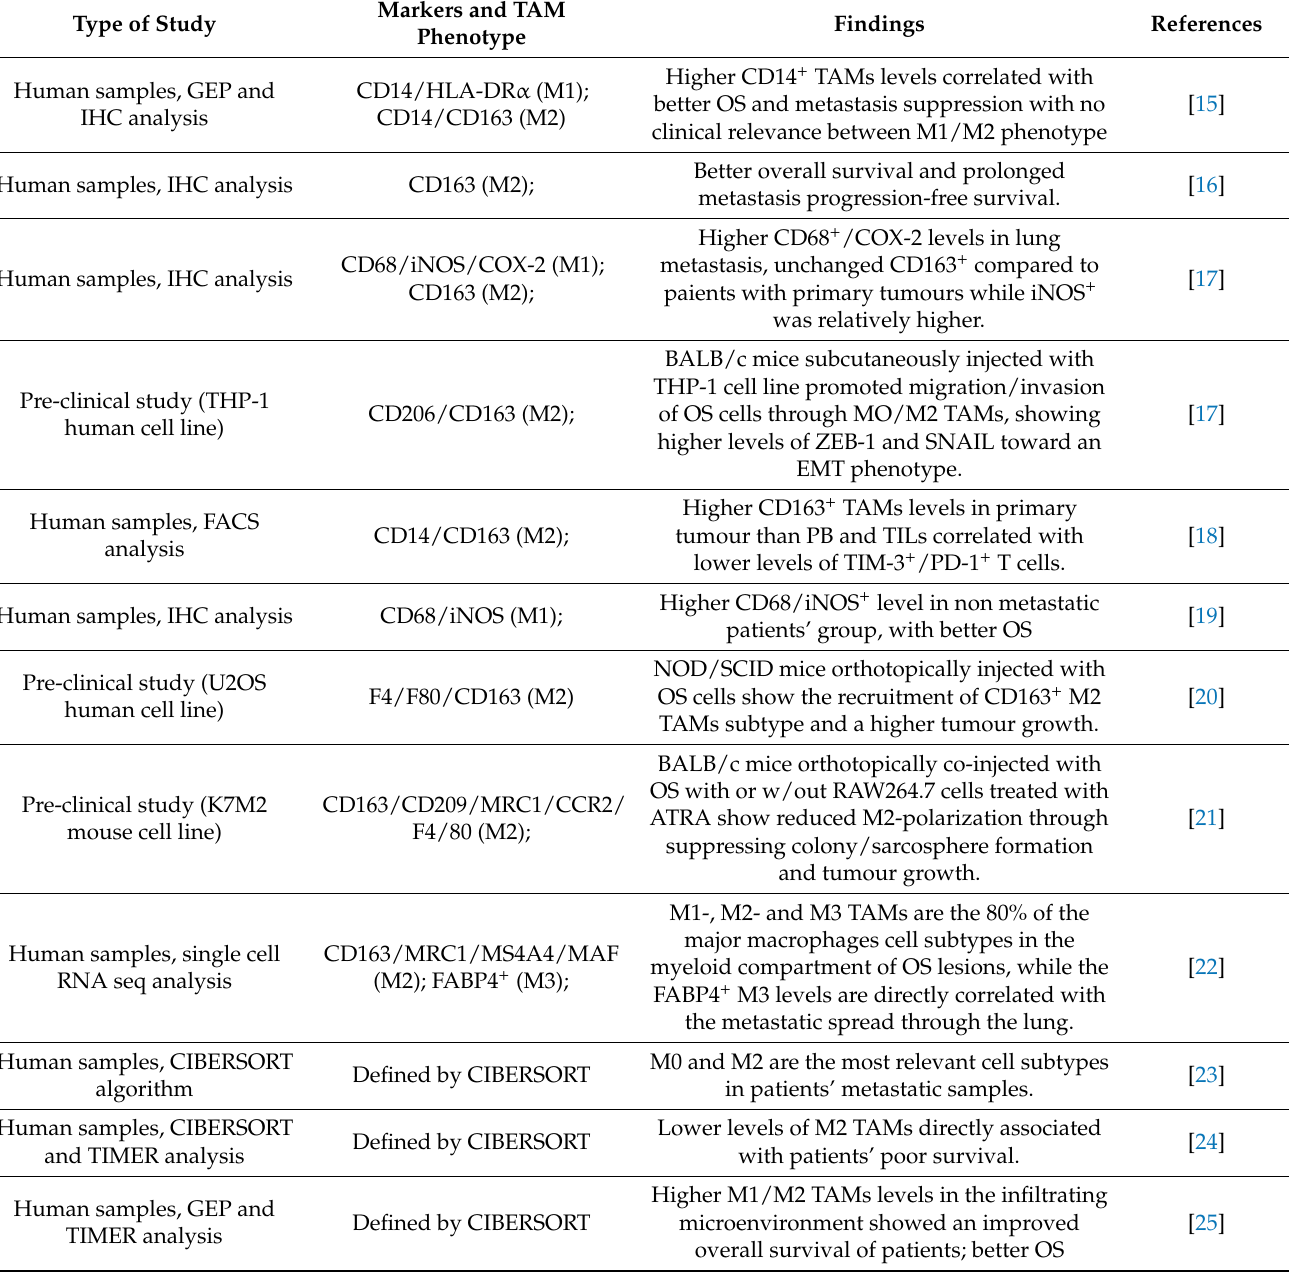
Table 1. Studies on the role of macrophages in